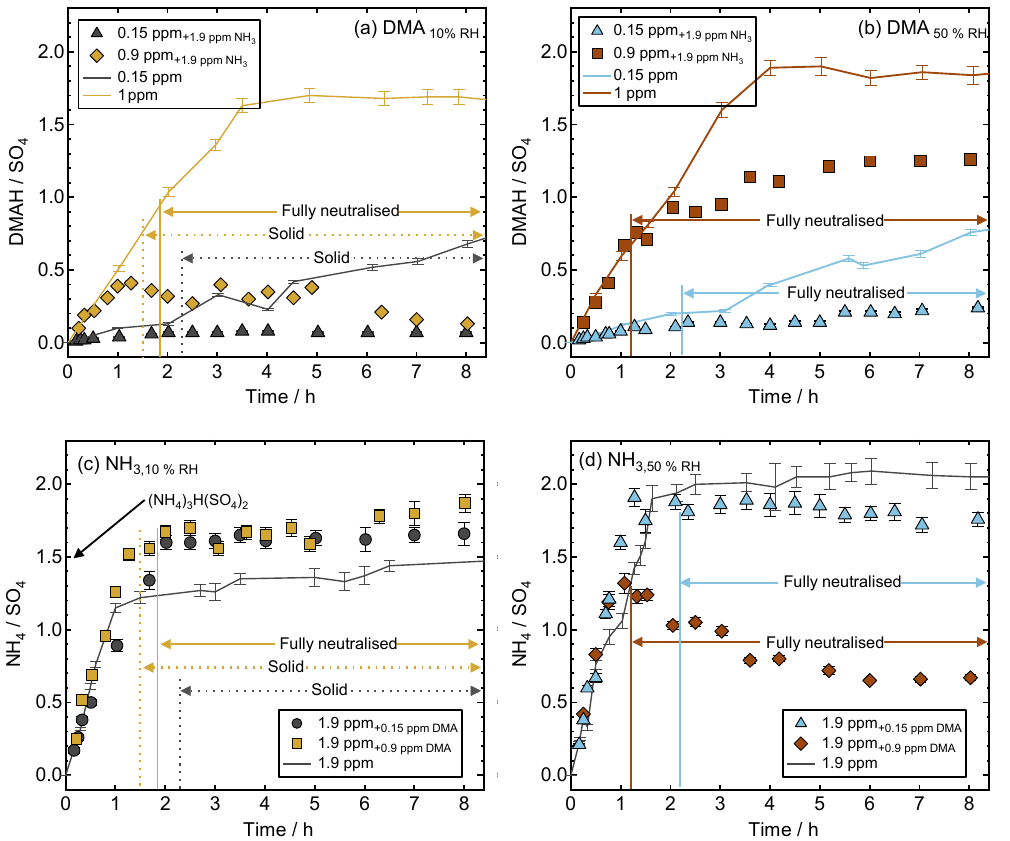
Figure 4. Comparison of particulate DMAH / SO 4 (a, b) and NH 4 / SO 4 (c, d) in single-gas uptake (line) vs. DMA-NH 3 co-uptake (symbols) into H 2 SO 4 at 10% RH (a, c) and 50% RH (b, d) , in the first 8h of reaction. Dashed vertical lines indicate phase transition of the majority of particles. Solid vertical lines indicate that particles reached a neutralisation ratio of two. Uncertainties from ion chromatography analysis are displayed on the vertical axis unless they are smaller than the